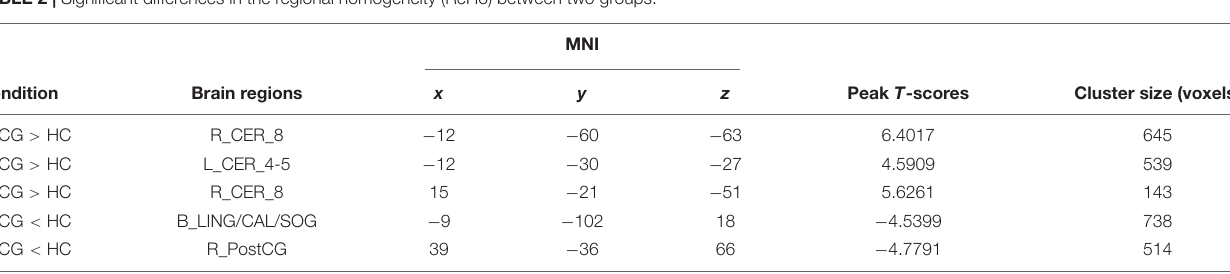
FIGURE 1 | One-sample t -test results of regional homogeneity (ReHo) maps within the primary angle-closure glaucoma (PACG) (A) and One-sample t -test results of ReHo maps within the healthy control (HC) (B) . ReHo, regional homogeneity; PACG, primary angle-closure glaucoma; HC, healthy control. TABLE 2 | Significant differences in the regional homogeneity (ReHo) between two